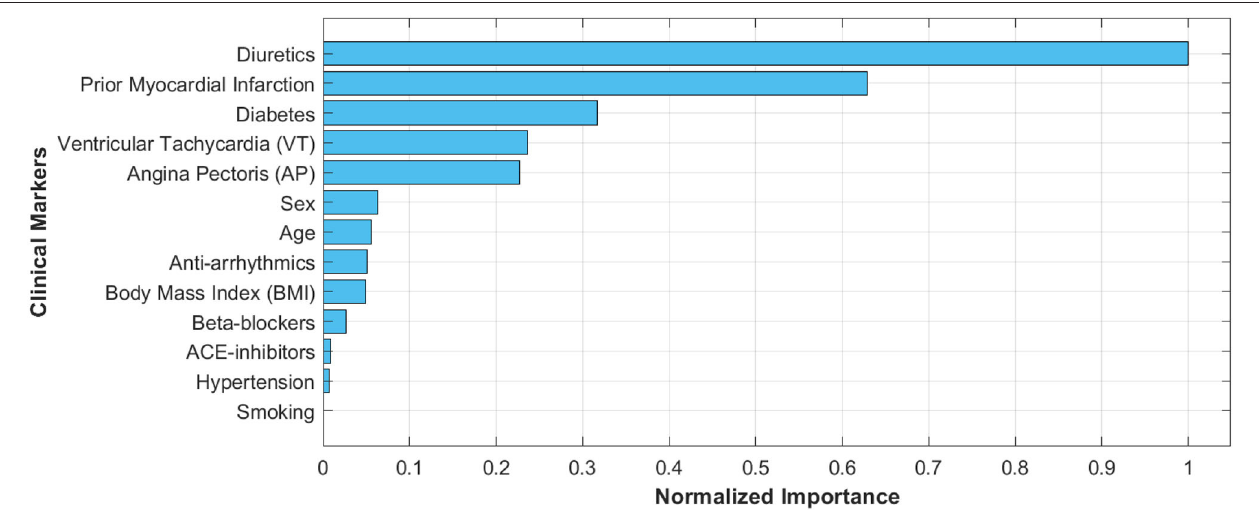
FIGURE 2 | Normalized importance scores for the clinical markers used in the study in differentiating between the three LVEF categories. Importance scores were calculated using the Chi-squared ( χ 2 ) statistical test.